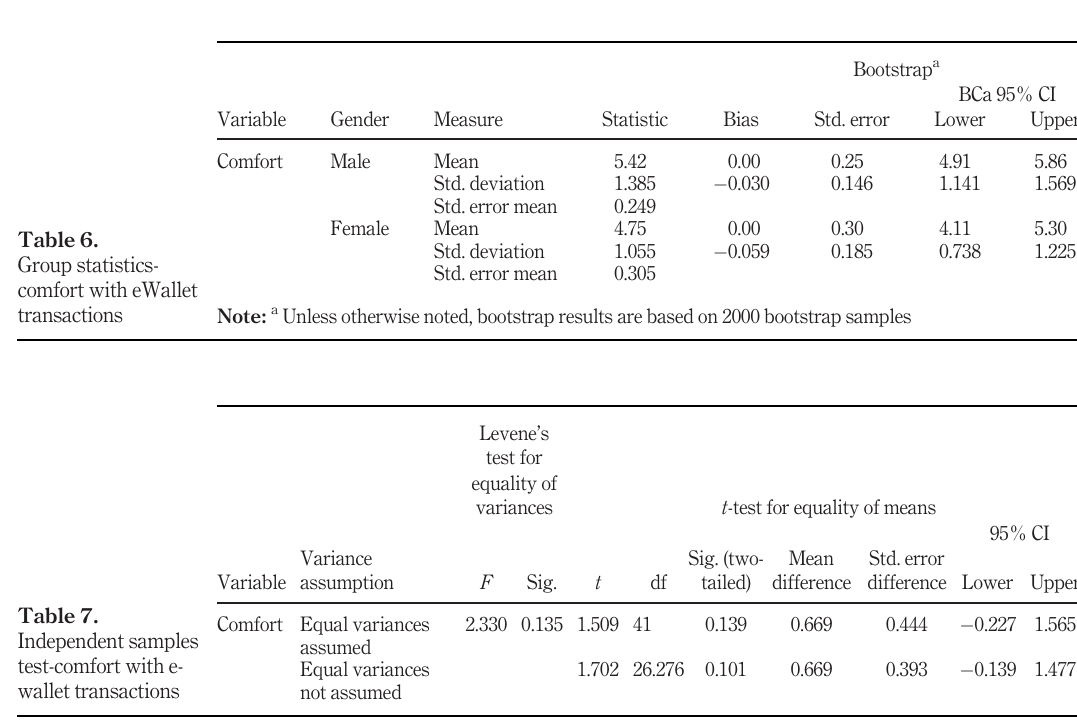
ffiffiffiffiffiffiffiffiffiffiffiffiffiffiffiffiffiffiffiffiffiffiffi s 1 : 509 2 1 : 509 2 þ 41